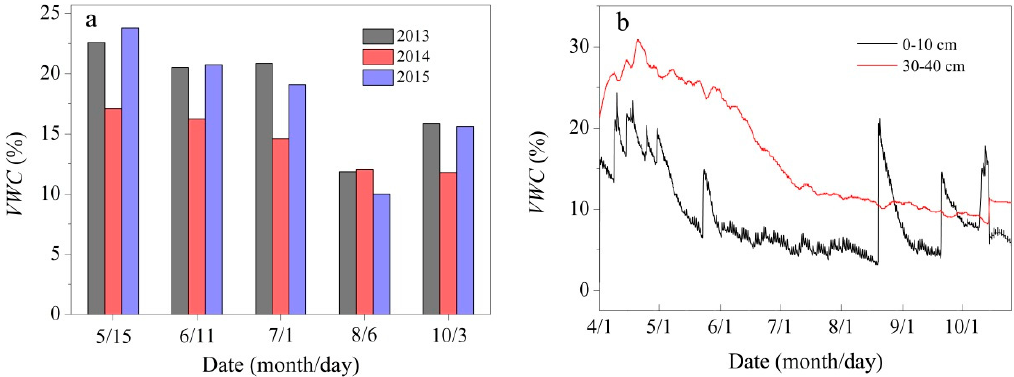
Figure 5. Comparison of soil volumetric water content ( VWC ) averaged over 0–40 cm for the years 2013–2015 ( a ) and the VWC at different depths in the growing season of 2014 ( b ).